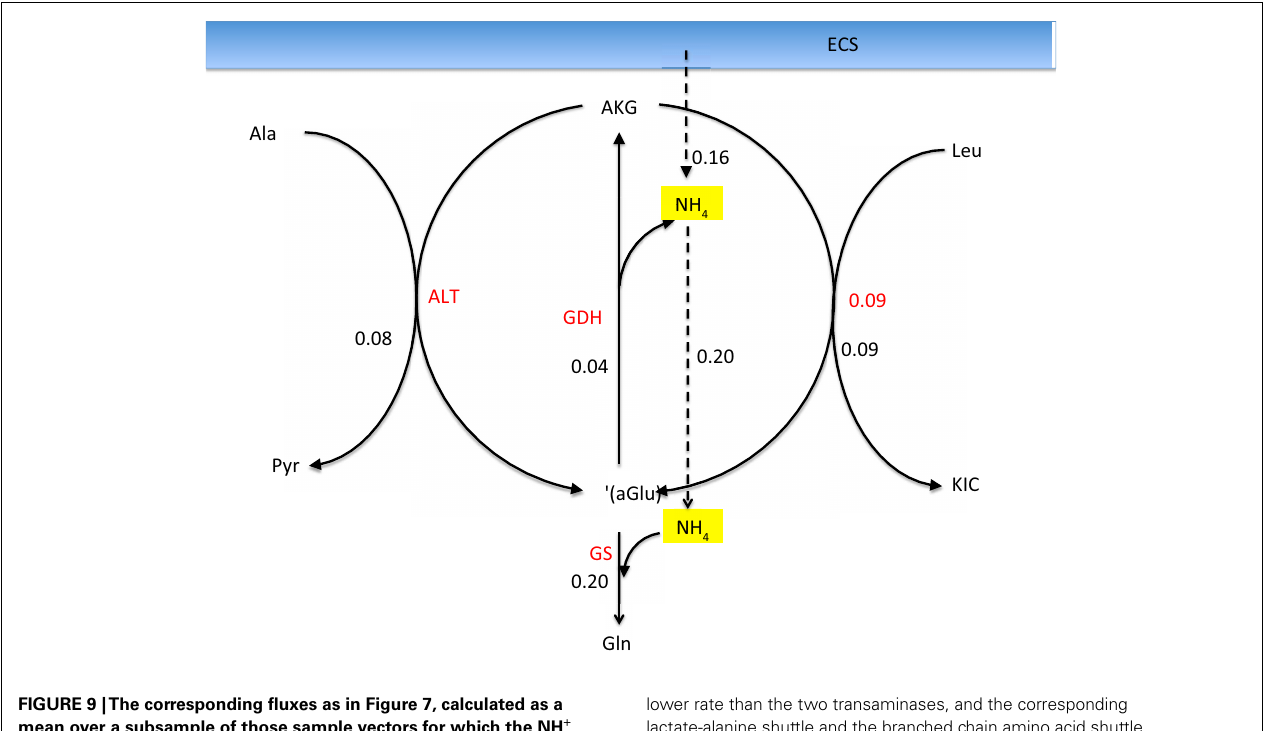
FIGURE 9 |The corresponding fluxes as in Figure 7, calculated as a mean over a subsample of those sample vectors for which the NH + flux is from ECS into the astrocyte .The ammonia influx and the GDH flux add up to equal the GS flux. Observe that the GDH runs at a much